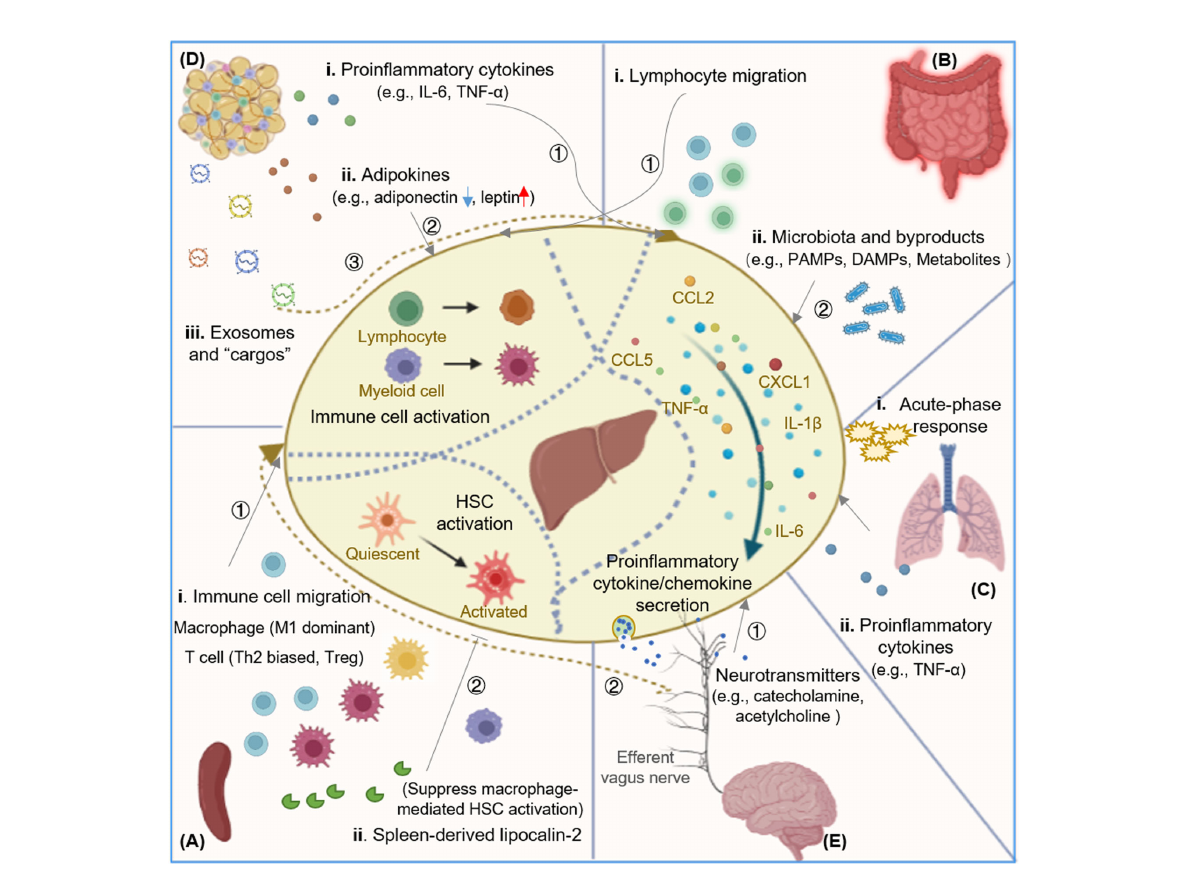
FIGURE 1 Mechanisms of extrahepatic factors regulating hepatic immunity. Extrahepatic factors in hepatic immune regulation. (A) Spleen and hepatic immune regulation. The spleen exerts its role in hepatic immune regulation by affecting the composition of both innate and adaptive immune cells. Spleen-derived Lcn-2 suppresses macrophage mediated HSC activation. (B) Gut and hepatic immune regulation. Intestinal microbiota and their byproducts (including PAMPs, DAPMs, and metabolites) could be translocated to the liver to active hepatic immune cells and promote the secretion of pro-in fl ammatory cytokines. Active lymphocytes could also be recruited from the gut into liver to modulate hepatic immunity. (C) Lung and hepatic immune regulation. Hepatic acute phase response is induced by the crosstalk between lung and liver communication, and pro-in fl ammatory cytokine like TNF-a acts as "shuttle" factor in modulating the lung-liver axis. (D) Adipose tissue and hepatic immune regulation. Adipose tissue-derived proin fl ammatory cytokines, adipokines, and exosomes modulate hepatic immunity by activating